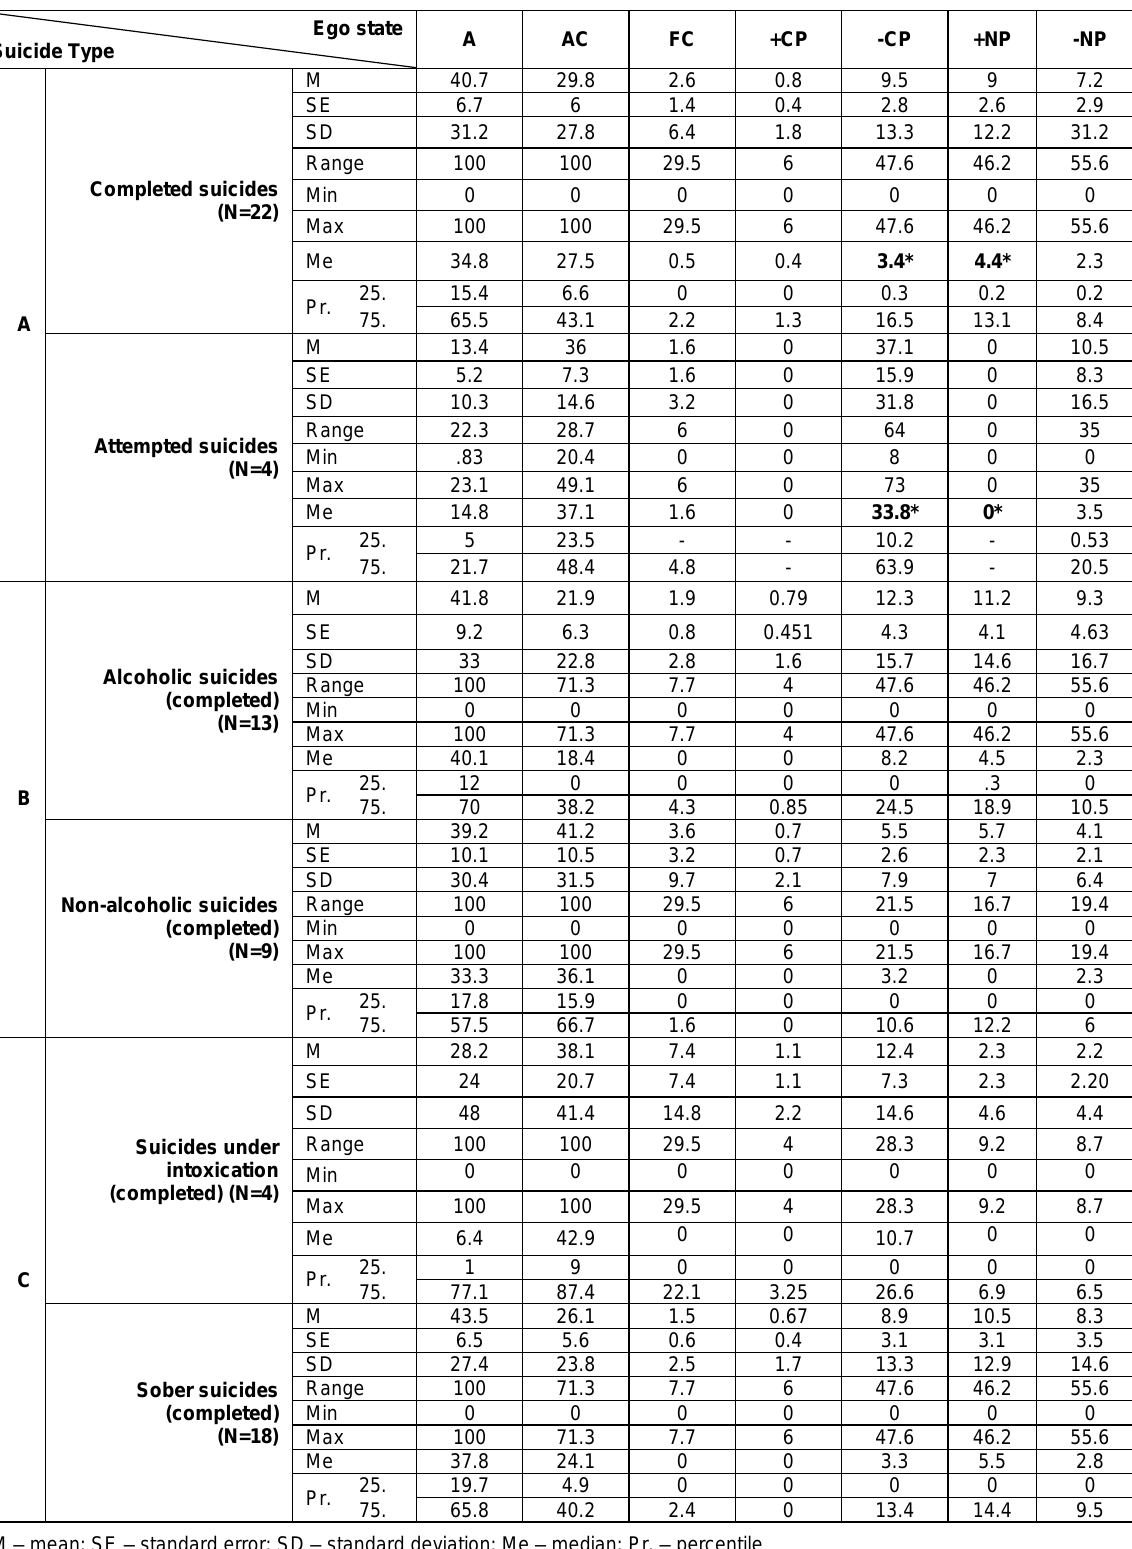
Table 2: Average Ego State Levels in Comparison